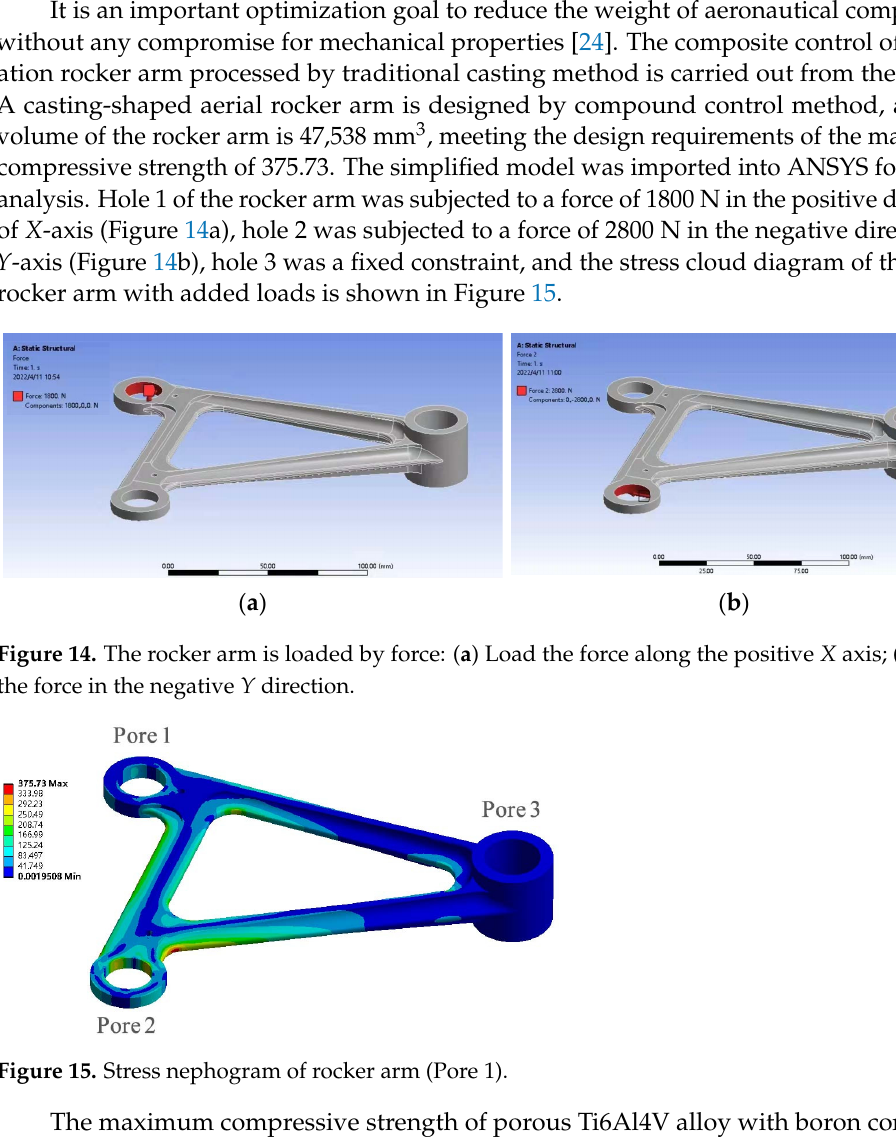
Figure 16. Porous rocker arm. 4. Conclusions In this work, based on the Gibson–Ashby empirical formula, the mechanical proper- ties of Ti6Al4V alloy prepared by SLM were characterized under the compound control of its porous structure and composition. The analytical relationships among pore param- eters, boron content, and the mechanical properties of the alloy were established. Further, substituting these analytical relationships into the Gibson–Ashby empirical formula, a